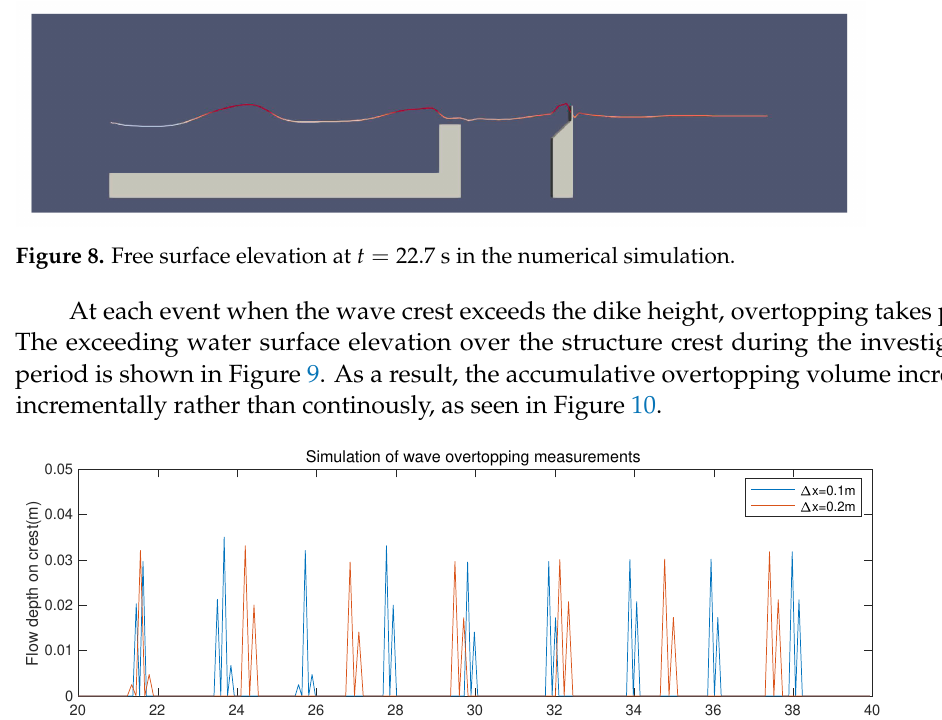
Figure 7. Free surface elevation at t = 22.5 s in the numerical simulation.